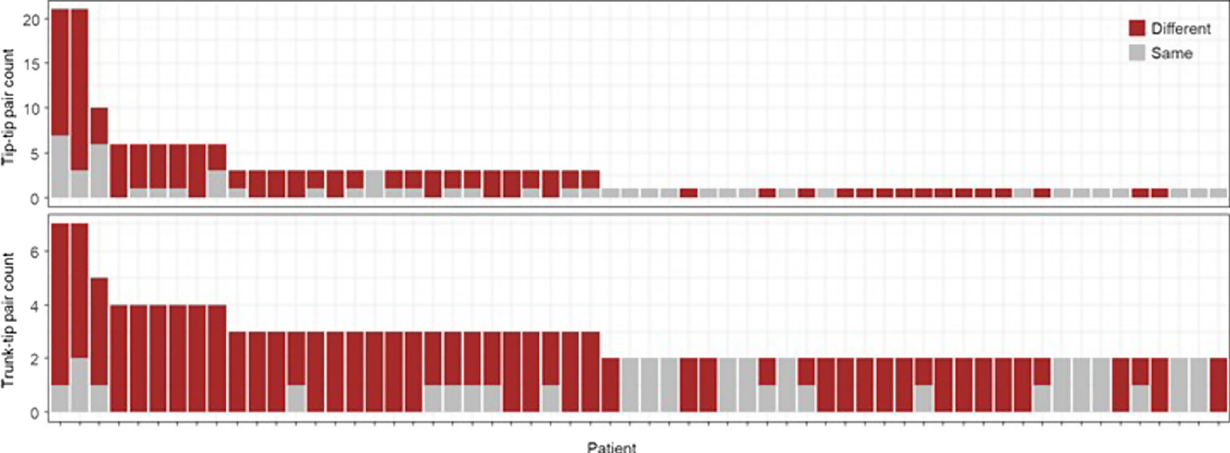
Fig. 8 Comparison of signature composition between a pair of branches. Counts of tip-tip branch pairs (top) and trunk-tip pairs (bottom) for each patient. Patients are ordered based on the number of branches in their clone phylogeny. The number of branch pairs containing different (brown) and same (gray) sets of signatures is